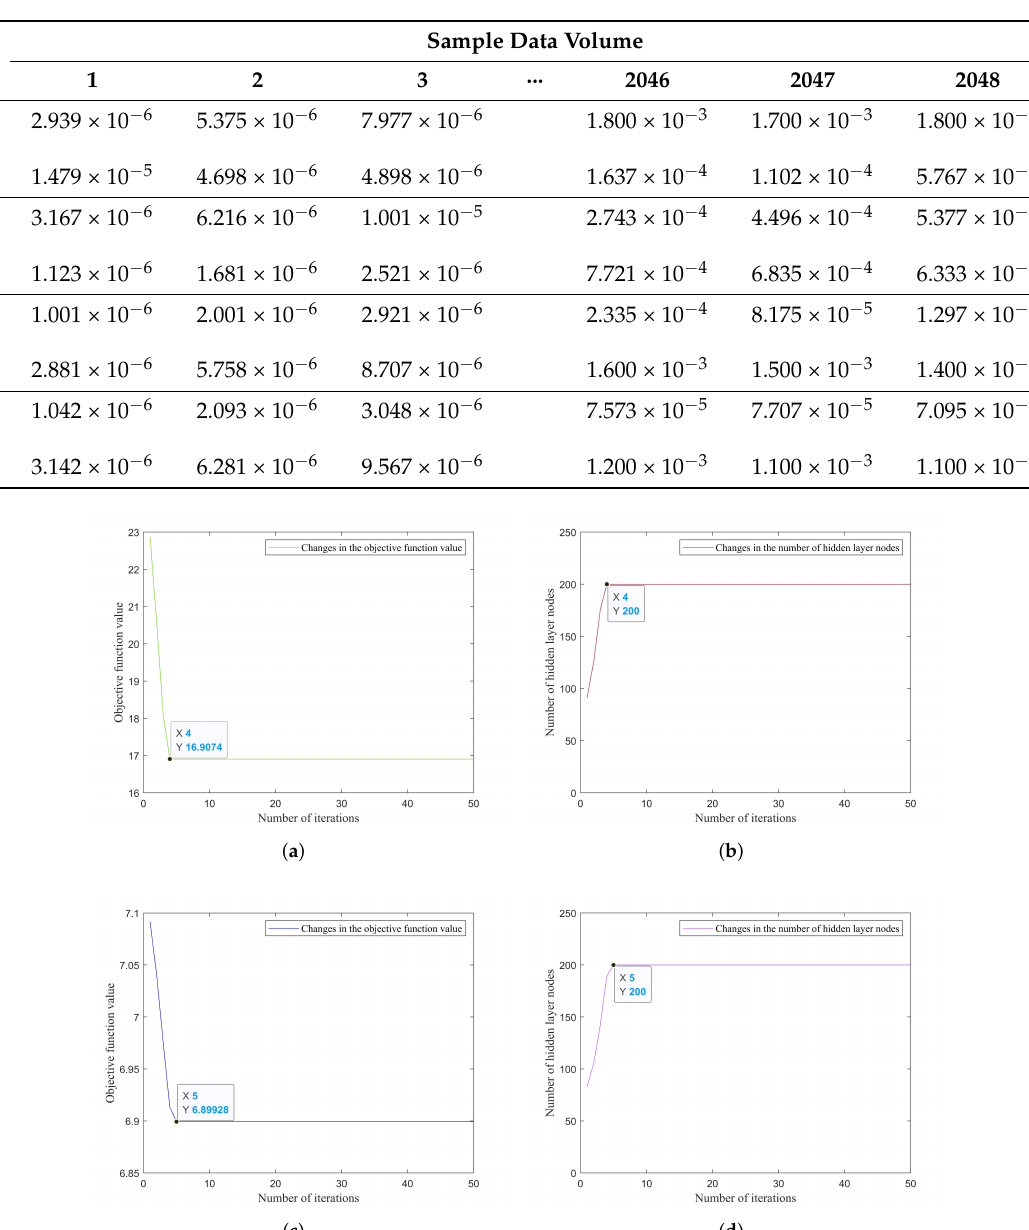
Table 4. Preprocessed data set T’ for 4 states of the ER-12K rolling bearing.